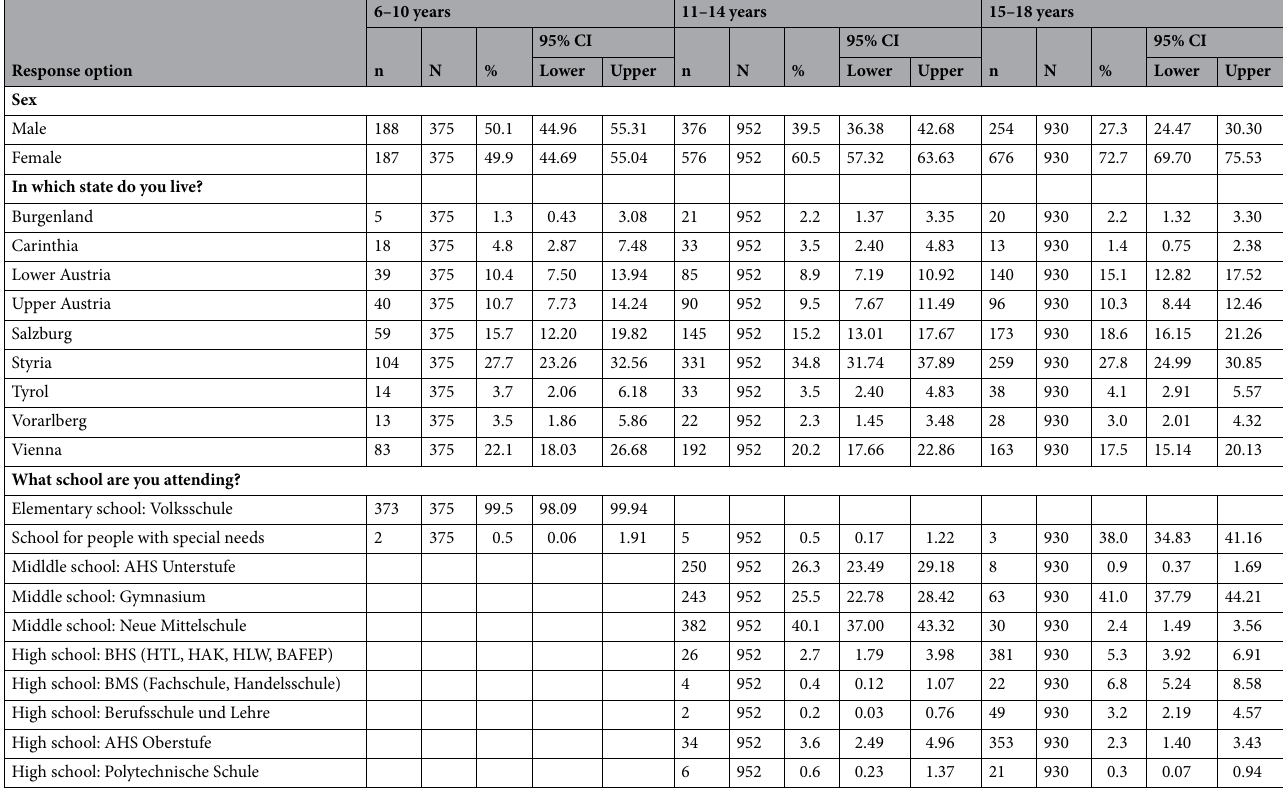
Table 1. Demographic characteristics of participants. CI, 95% confidence interval with lower and upper border; empty spaces response option was not chosen in this age